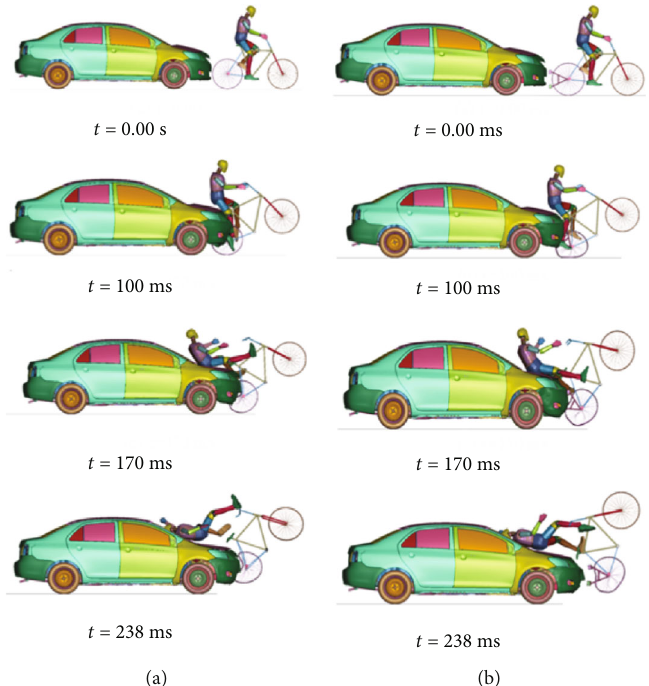
Figure 12: Cyclist overtaking impact at 40 km/h without a passive safety system (a) and passive safety system